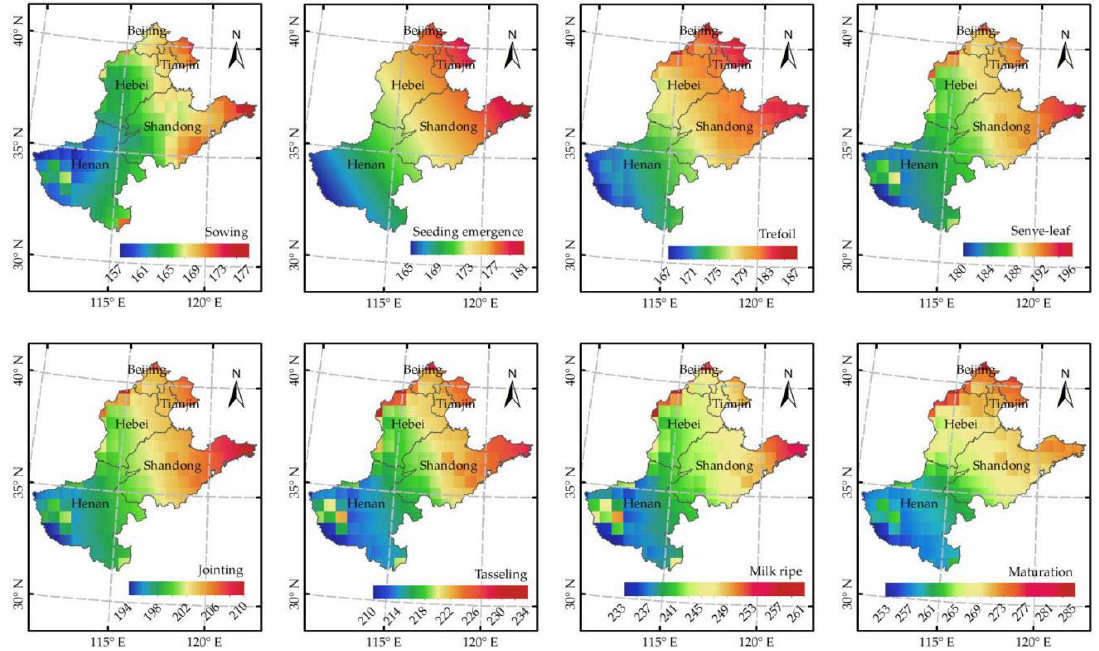
Figure 8. The simulated maize phenology using environmental factors in Huanghuaihai Plain in 2012.